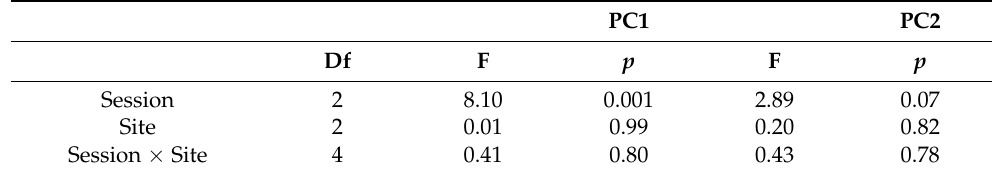
Figure 6. Spearman correlations between the I2M2, the five taxonomy-based and trait-based metrics in terms of Ecological Quality Ratio (ASPT: Average Score Per Taxon, Richness: taxonomic richness, Shannon: Shannon’s diversity index, Ovoviviparity: relative abundance of ovoviviparous species, polyvoltinism: relative abundance of the polyvoltine species) and the 12 water quality and habitat degradation pressure categories (PAH: polycyclic aromatic hydrocarbons). The values represent the correlation coefficients. The colored squares represent the significant coefficients (red or blue, p -value < 0.05) according to the scale of the values indicated on the right of the correlogram. The black lines are used to visually separate the I2M2, the five taxonomy-based and trait-based metrics from the 12 water quality and habitat degradation pressure categories. Table 5. Results of the two-way ANOVA with random effects for the stream, the session, the sampling site, and their interaction on the two first dimensions of the PCA (Df = degree of freedom; F: F value; p : p